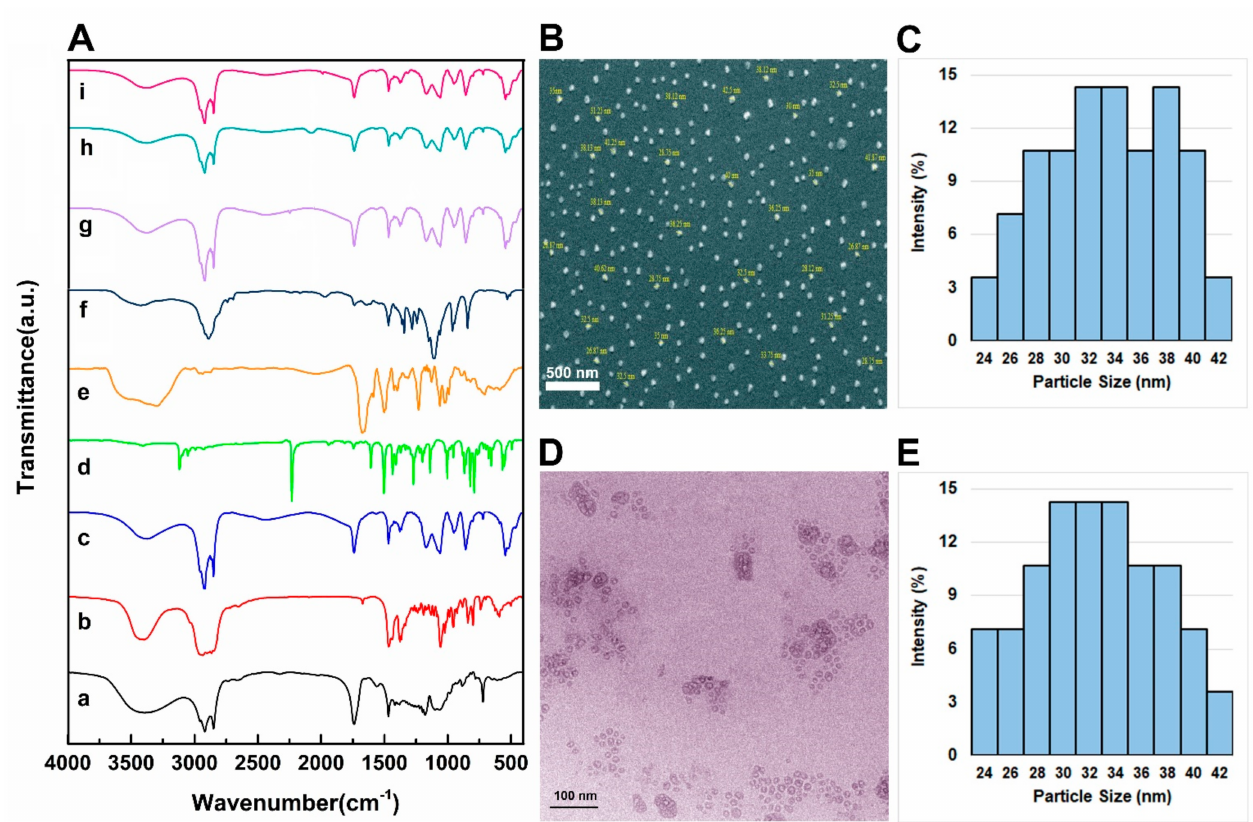
Figure 1. ( A ) FTIR spectra of different niosomal formulations and their component including (a) Span 60, (b) cholesterol, (c) unloaded niosomes, NL, (d) Let, (e) Cyclo, (f) folic acid, (g) niosomal Let, (h) niosomal Cyclo, and (i) NLCPFA; ( B ) FE-SEM image of NLCPFA; ( C ) average particle size and particle size distributions obtained by SEM image with an average of 33.8 nm; ( D ) TEM images of NLCPFA; ( E ) particle size and distributions by TEM images with an average of 27.9